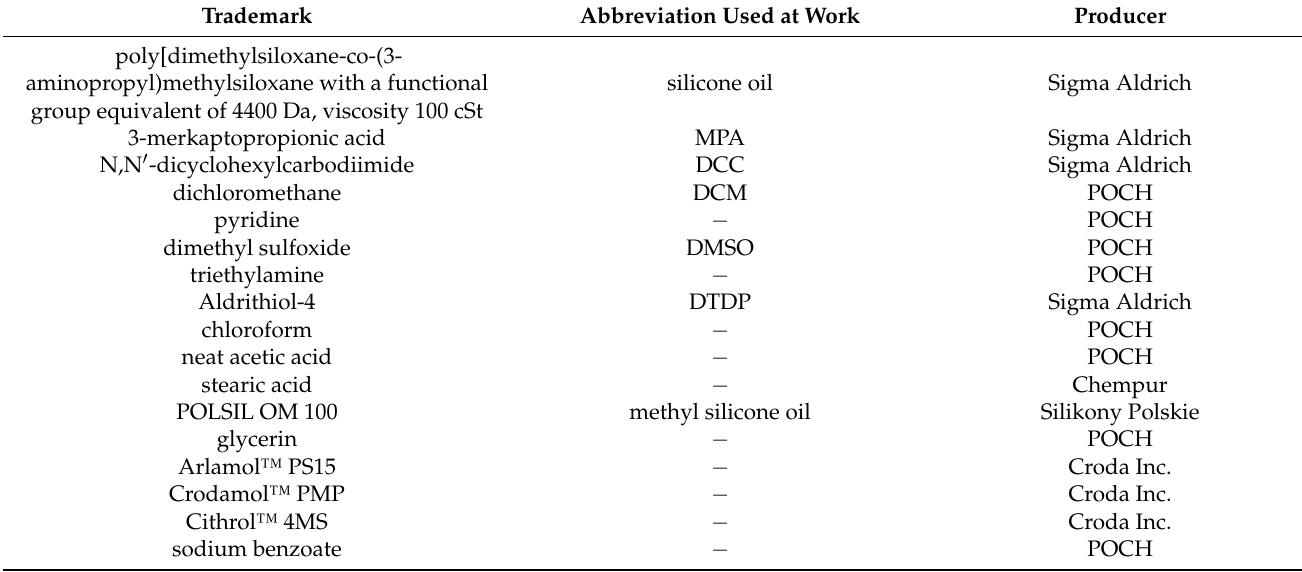
Table 1. Materials used in investigation.